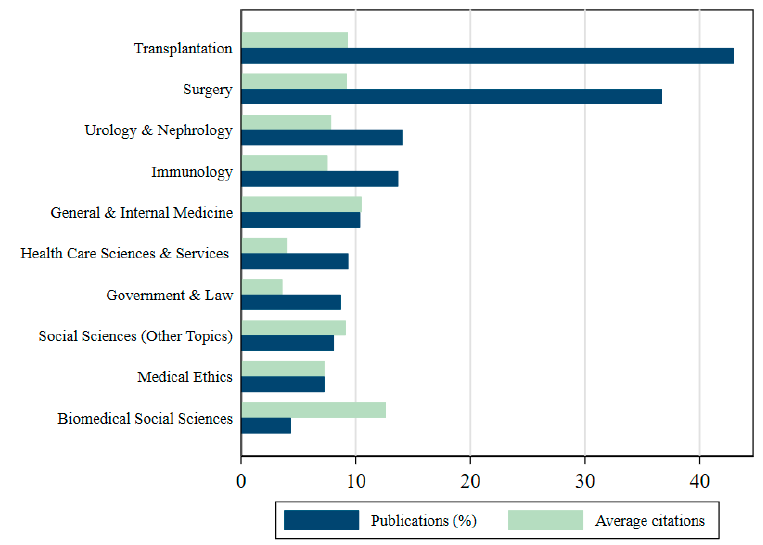
Figure 4. Top ten research areas in THBOR literature. Publications can simultaneously belong to more than one research area (percentages are out of 100).